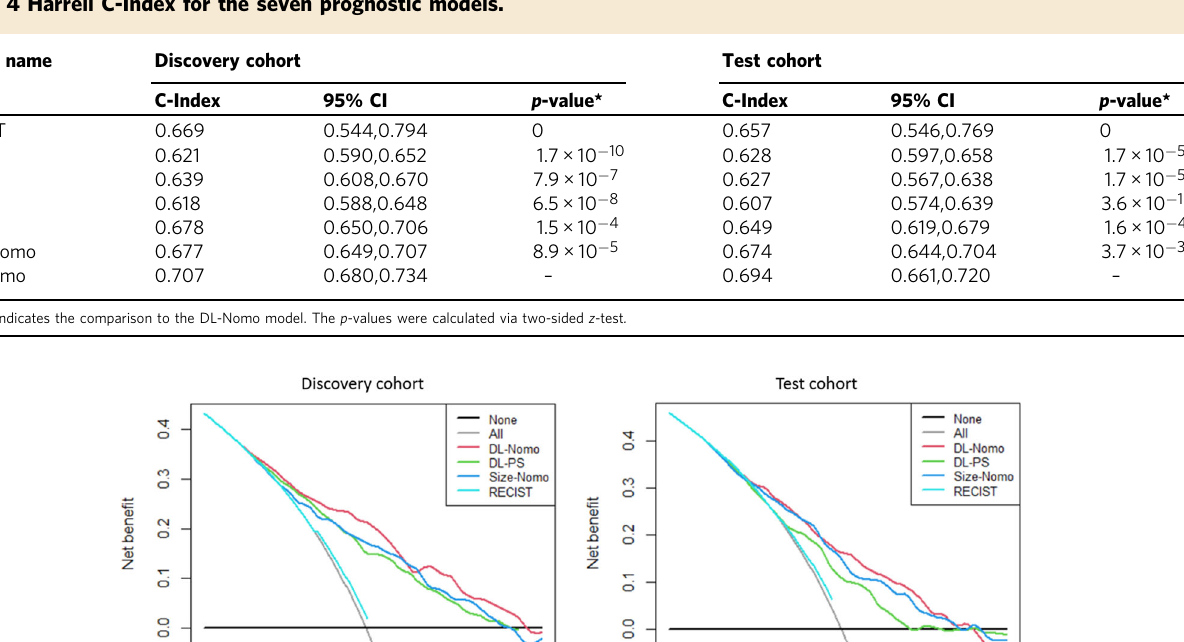
Table 4 Harrell C-Index for the seven prognostic models.